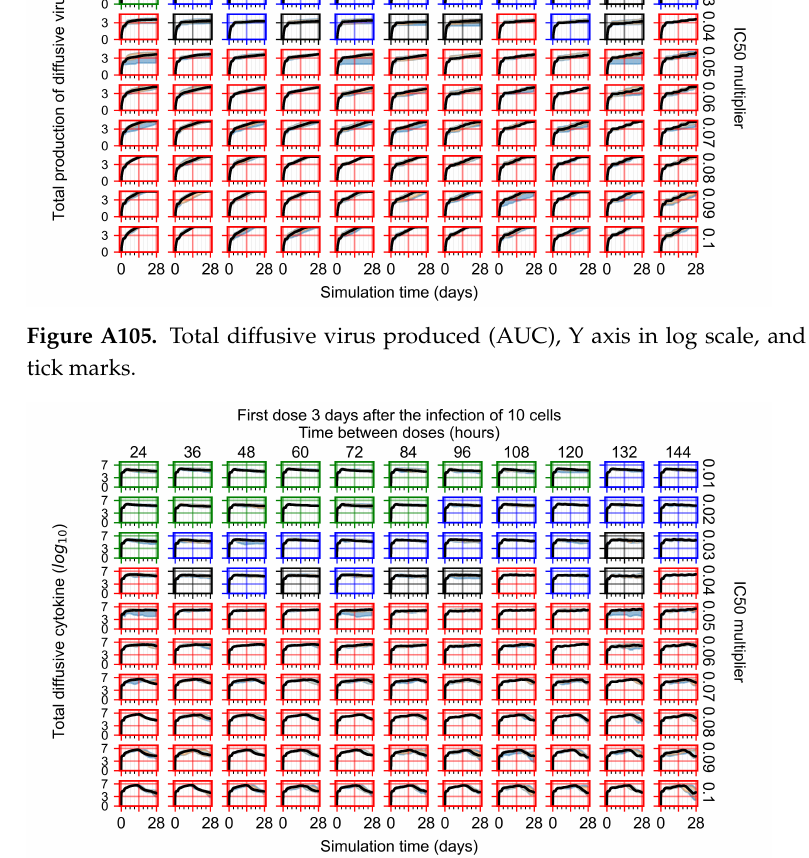
Figure A106. Diffusive cytokine amount, Y axis in log scale, and exponent values as tick